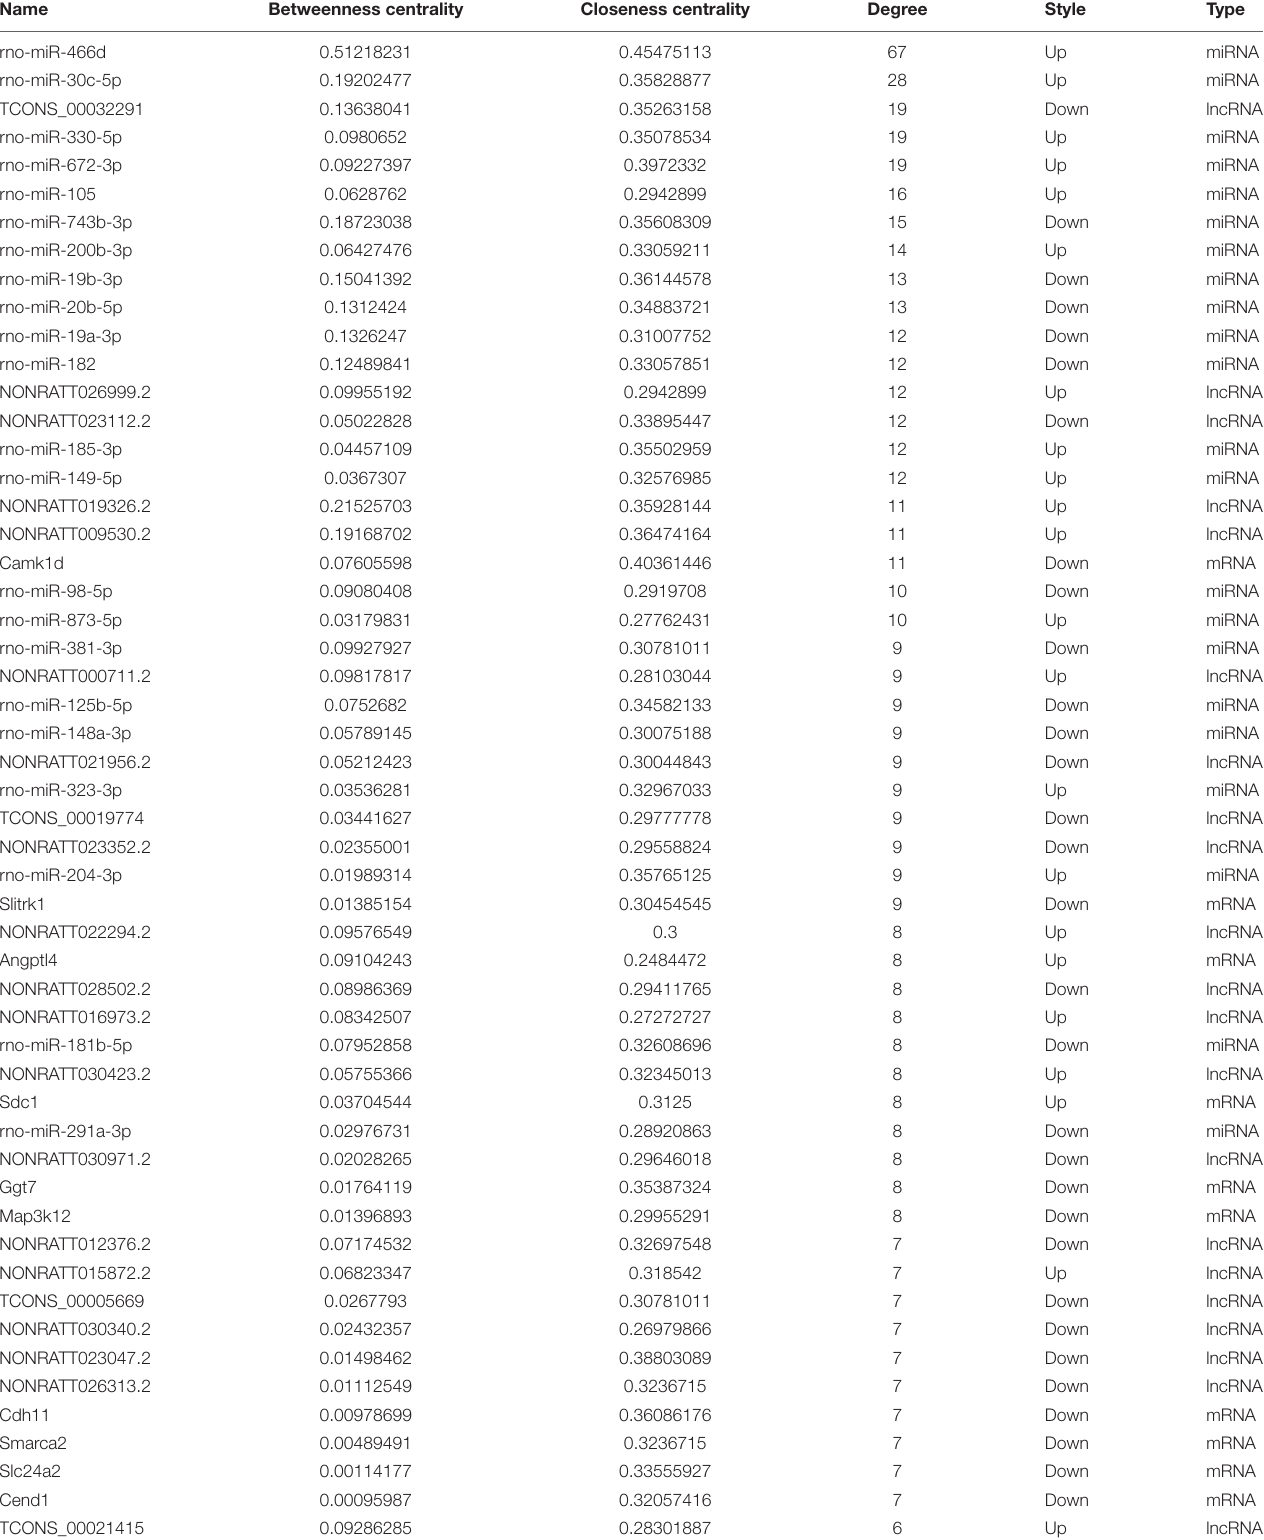
TABLE 4 | The list of differentially expressed genes in the lncRNAs-miRNAs-mRNAs regulatory ceRNA network (node degree >